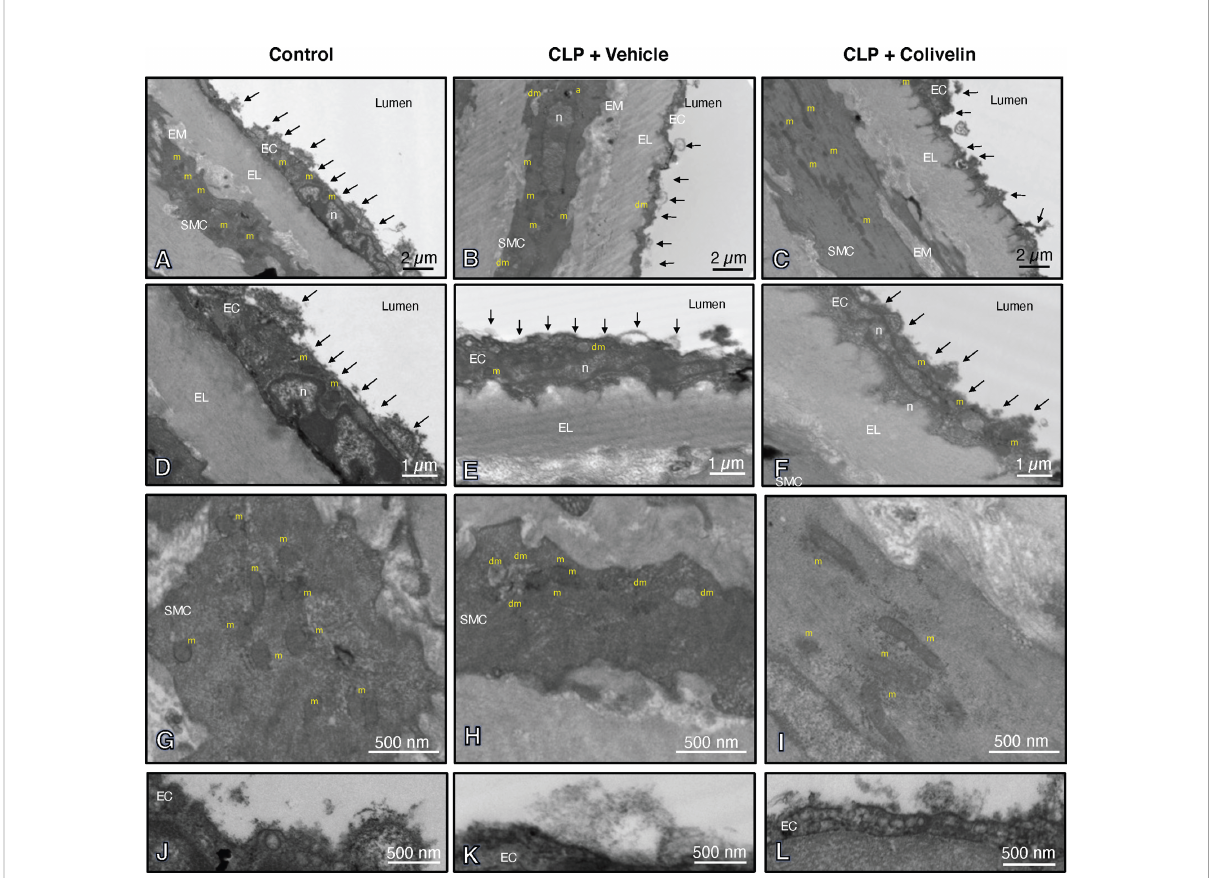
FIGURE 6 Transmission electron microscopy sections of thoracic aortas with lanthanum staining at 6 h after cecal ligation and puncture (CLP). Panels of control mice (A, D, G, J) show thick endothelial glycocalyx layer with dense individual bundles and normal mitochondria in endothelial and smooth muscle cells. Panels of vehicle-treated mice (B, E, H, K) show thin glycocalyx with bundles with loose structure and some damaged mitochondria and authophagic vesicles at 6 h after CLP. Panels of colivelin-treated mice (C, F, I, L) show well preserved thin glycocalyx and normal mitochondria at 6 h after CLP. Vehicle (200 µl distilled water) or colivelin (100 µg/kg) was administered intraperitoneally at 1 h after CLP. Arrows = glycocalyx; EC = endothelial cell; EL = elastica lamina; EM = extracellular matrix; RC = red cell; SMC = smooth muscle cell; a = authophagosome; n = nucleus; m = normal mitochondria; dm = damaged swollen mitochondria presenting translucent matrix and disrupted